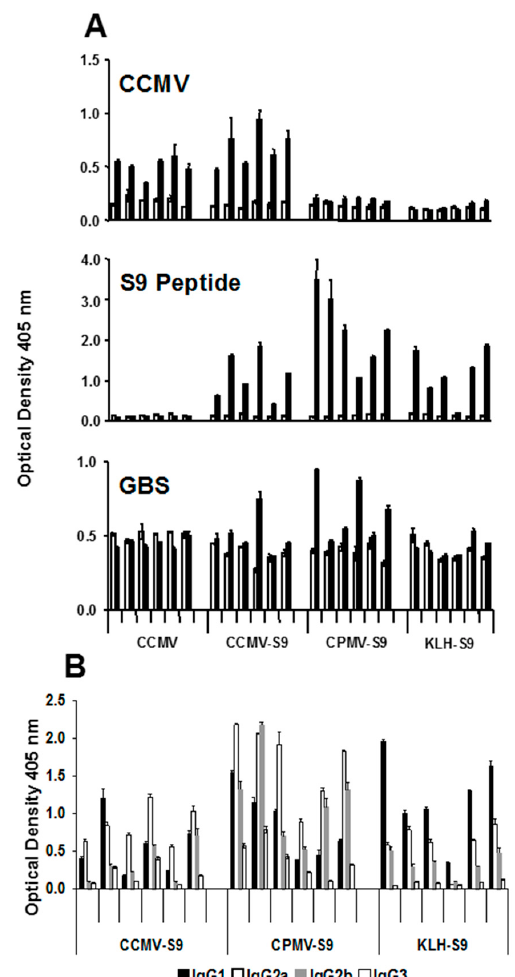
Figure 4. Antibody responses in a second experiment. Groups of six mice were immunized with CCMV, CCMV ‐ S9, CPMV ‐ S9, and KLH ‐ S9 with no adjuvant. In panel A, prebleed (open bar) and post ‐ immune serum (filled bar) were tested for binding to CCMV, S9 peptide, and GBS and detected with alkaline phosphatase–conjugated anti ‐ mouse IgG (H + L). In panel B, the sera are tested for IgG subclass of antibody to the S9 peptide.